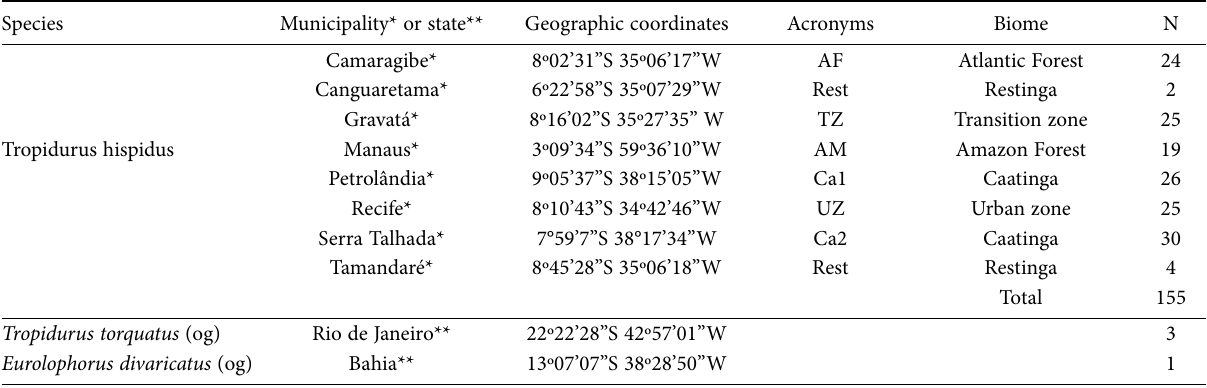
Table 1. Number (N) of Tropidurus hispidus, T. torquatus , and Eurolophosaurus divaricatus specimens captured in each site along the study area.